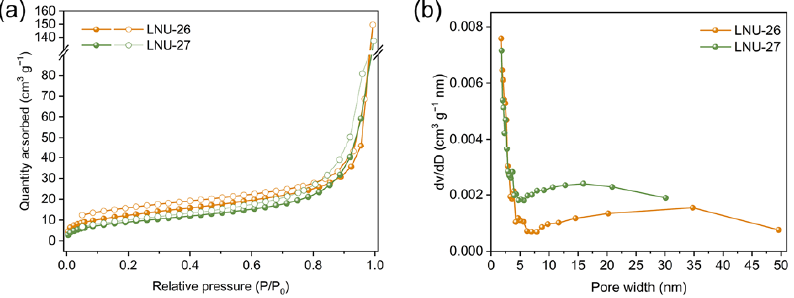
Figure 2. ( a ) N 2 adsorption and desorption isotherms of LNU-26 and LNU-27 recorded at 77 K; ( b ) pore size distributions of LNU-26 and